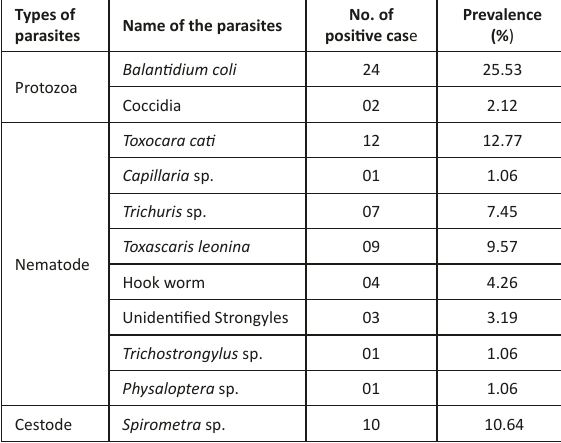
Table 2. Prevalence of parasites in different animals at Dhaka zoo